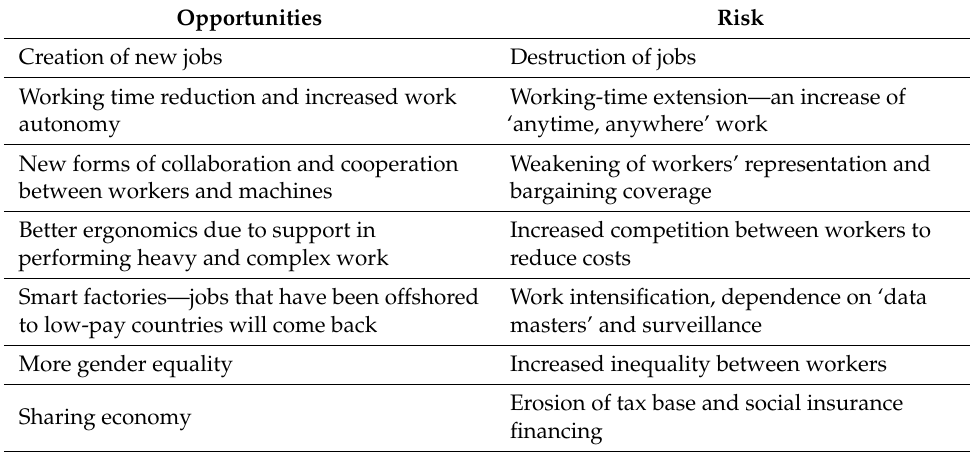
Table 1. Opportunities and risks in